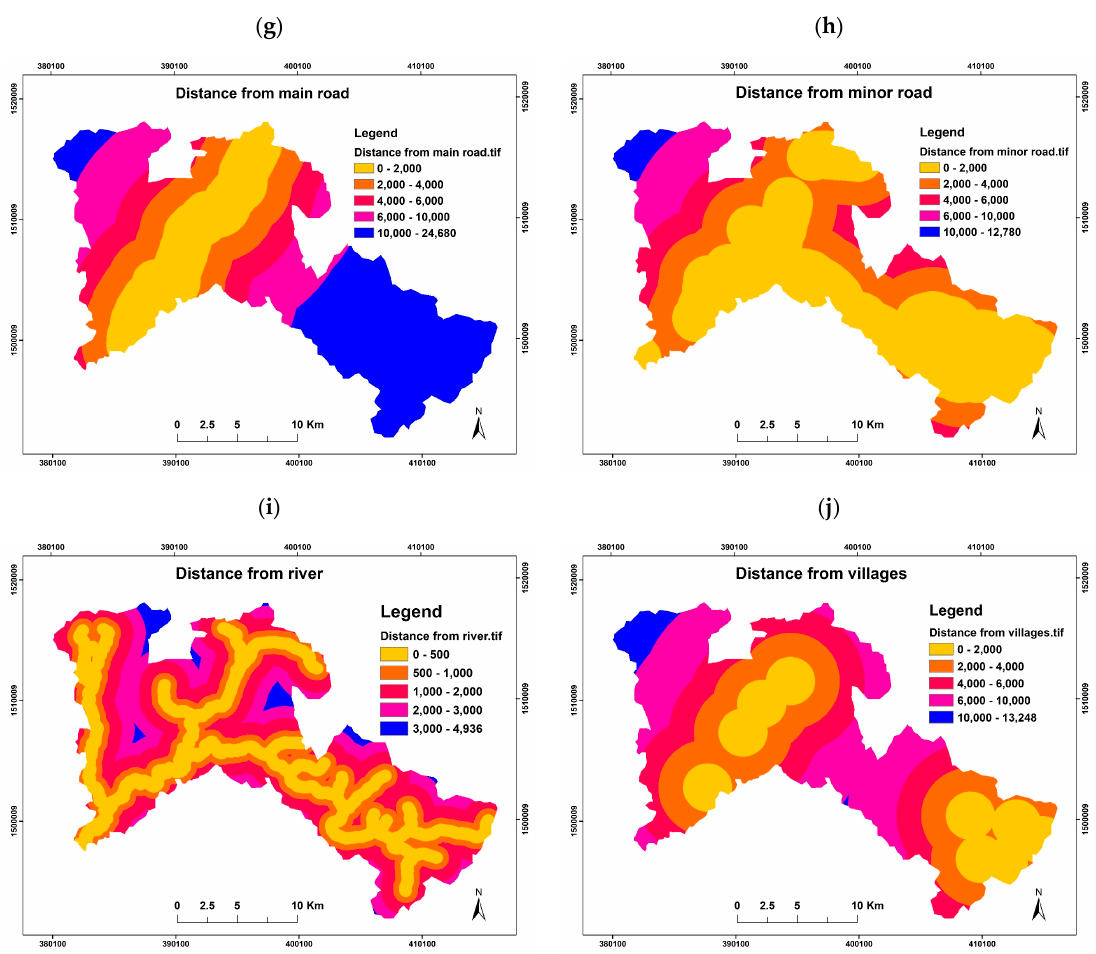
Figure 3. LULC map of upstream Siem Reap River in year: ( a ) 1998, ( b ) 2008, and ( c ) 2018 and the different drivers in LULC change in the study: ( d ) Digital elevation model, ( e ) slope, ( f ) aspect, ( g ) distance from main road, ( h ) minor road, ( i ) distance from river, and ( j ) distance from villages (distance unit is meter).